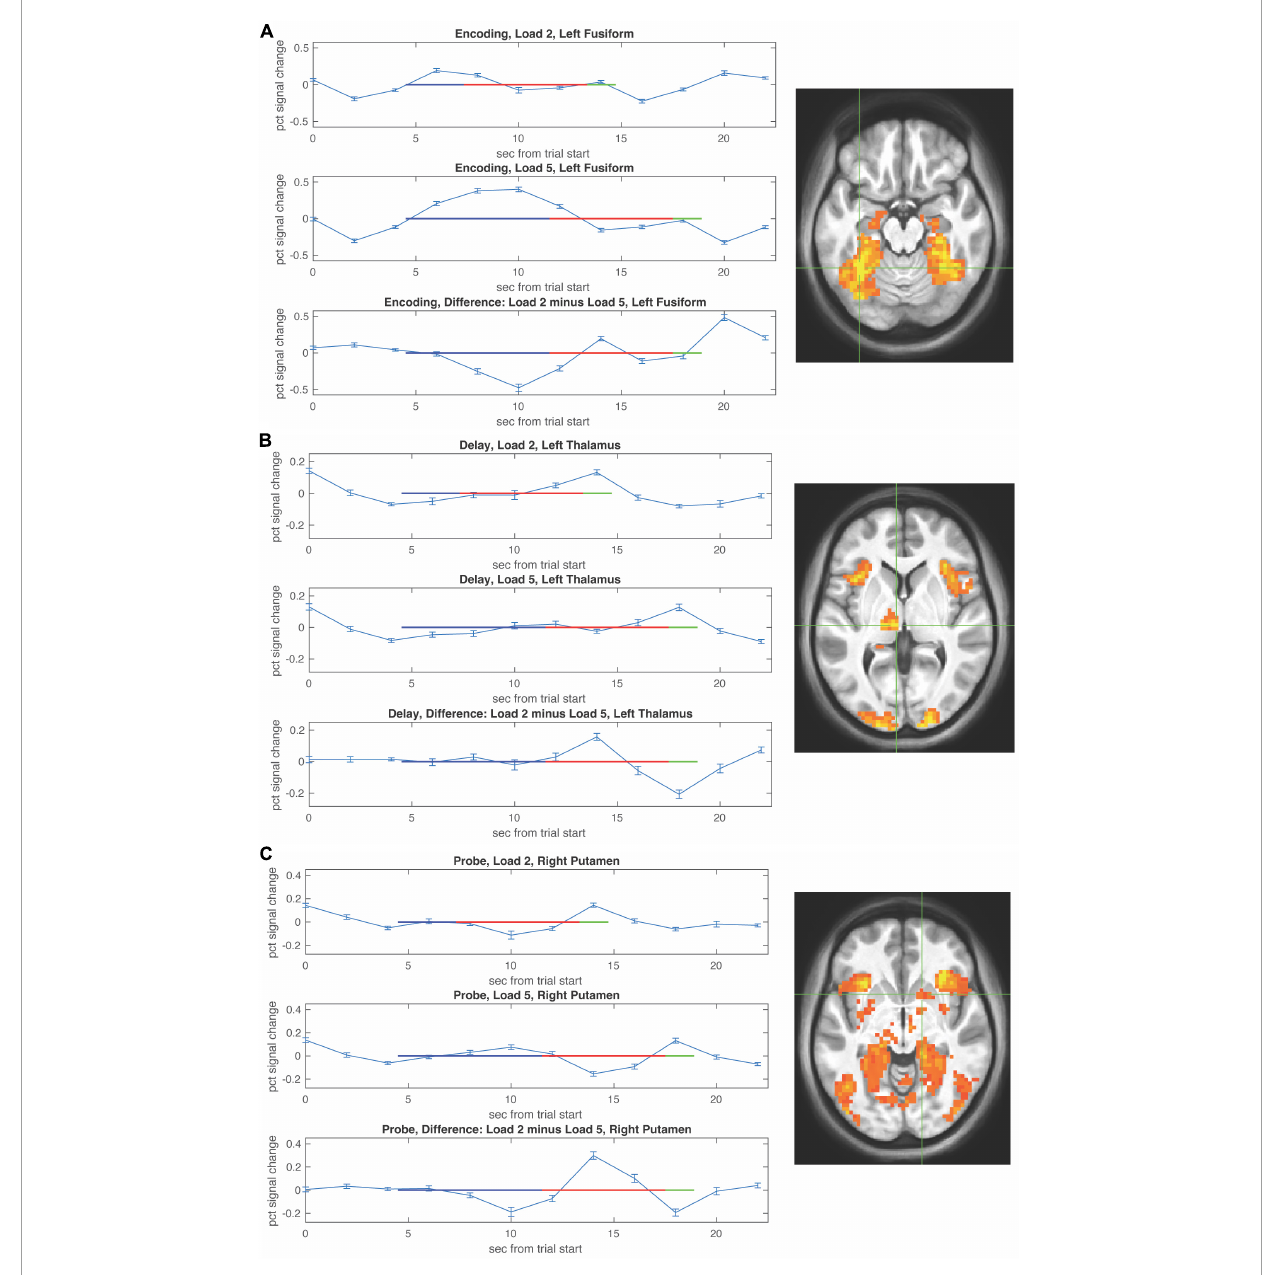
FIGURE3 Functional magnetic resonance imaging (fMRI) timecourses as a function of load during the encoding, delay, and probe periods. Timecourses (mean ± S.E.M) are shown for local maxima during encoding in left fusiform (A) , during the delay period in left thalamus (B) , and during the probe choice period in right putamen (C) . For each timecourse low load is shown in the upper panel, high load is shown in the middle panel, and the difference (low–high) is shown in the bottom panel. The encoding period is depicted by a blue horizontal line, the delay period by a red horizontal line, and the probe period by a green horizontal line with beginning of the lines shifted by the hemodynamic